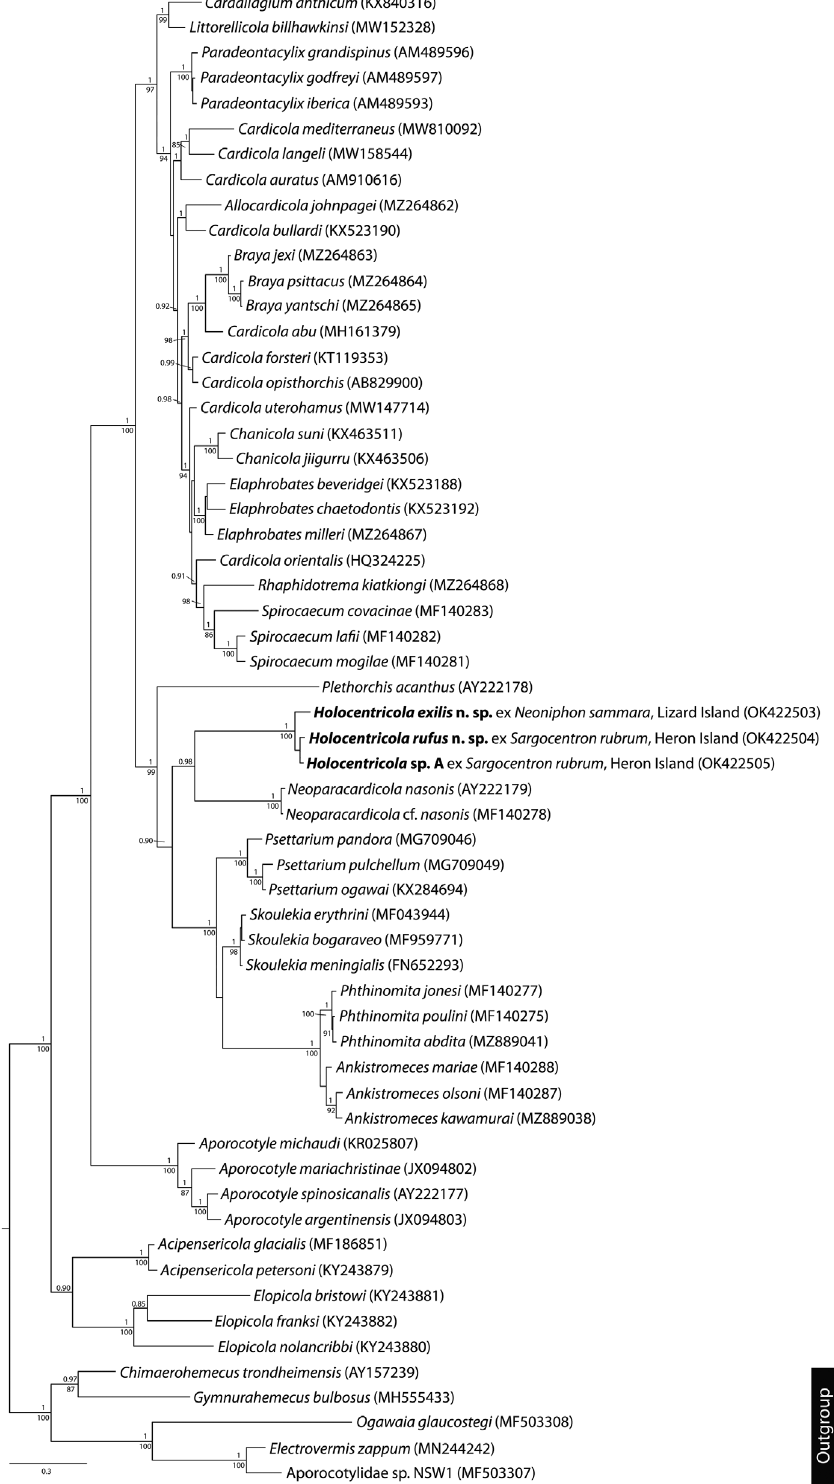
Figure 4. Relationships between species of Holocentricola and other members of the Aporocotylidae based on phylogenetic analysis of the 28S dataset. Bayesian inference posterior probabilities values are shown above the nodes and maximum likelihood bootstrap support shown below; values of <85 and <0.85 not shown. The scale-bar indicates expected number of substitutions per